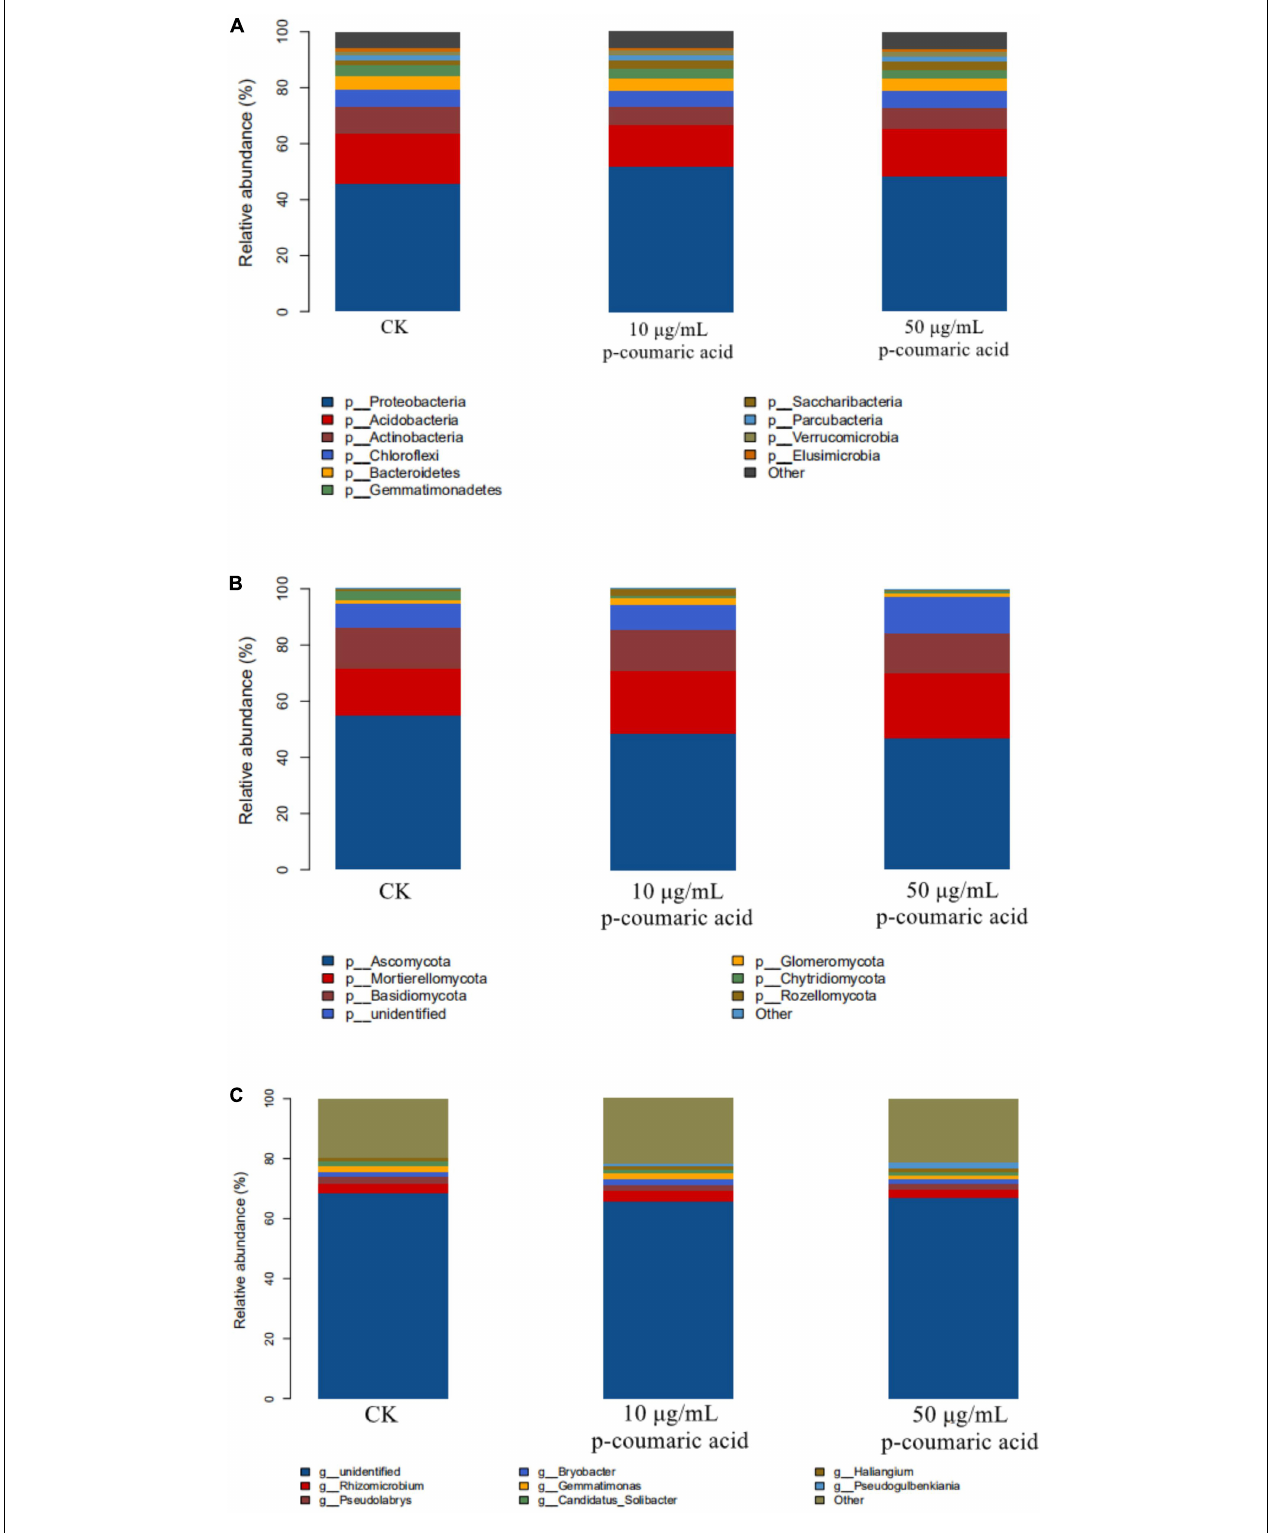
FIGURE 11 | The relative abundance (%) of adding p-coumaric acid alfalfa rhizosphere soils, five repetitions per soil samples. (A) Major bacteria phylum, (B) major fungi phylum, (C) major bacteria genus.